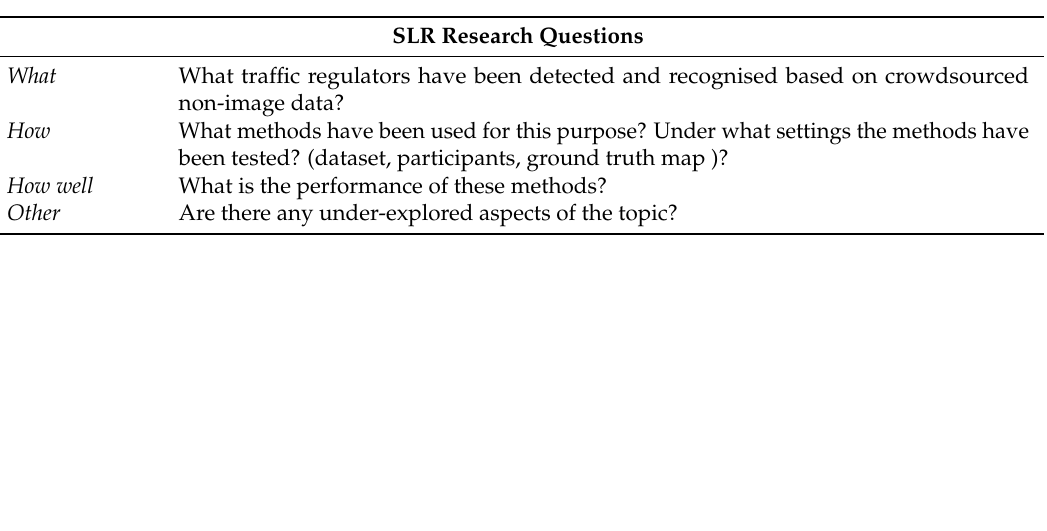
Table 1. The Systematic Literature Review (SLR) objectives formulated as research